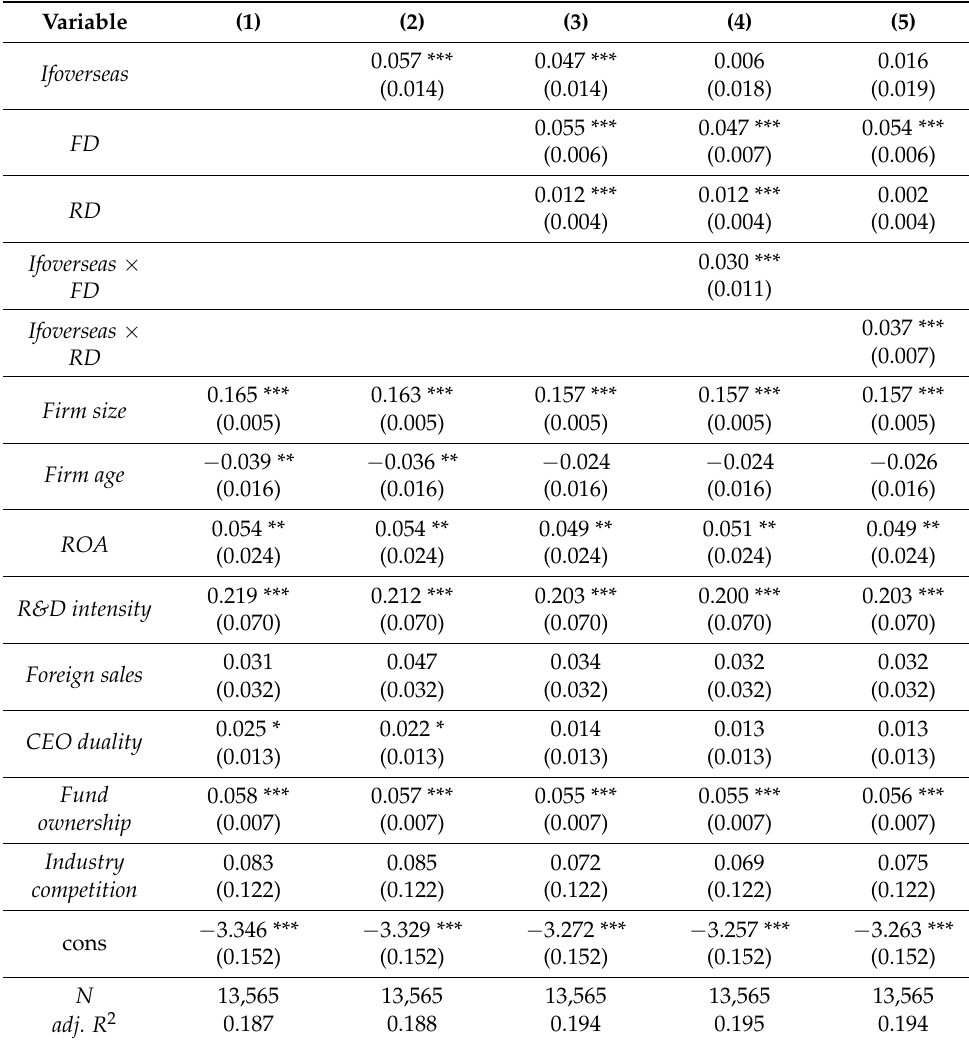
Table 6. Robustness Checks: Alternative Proxy for TMTs’ Overseas